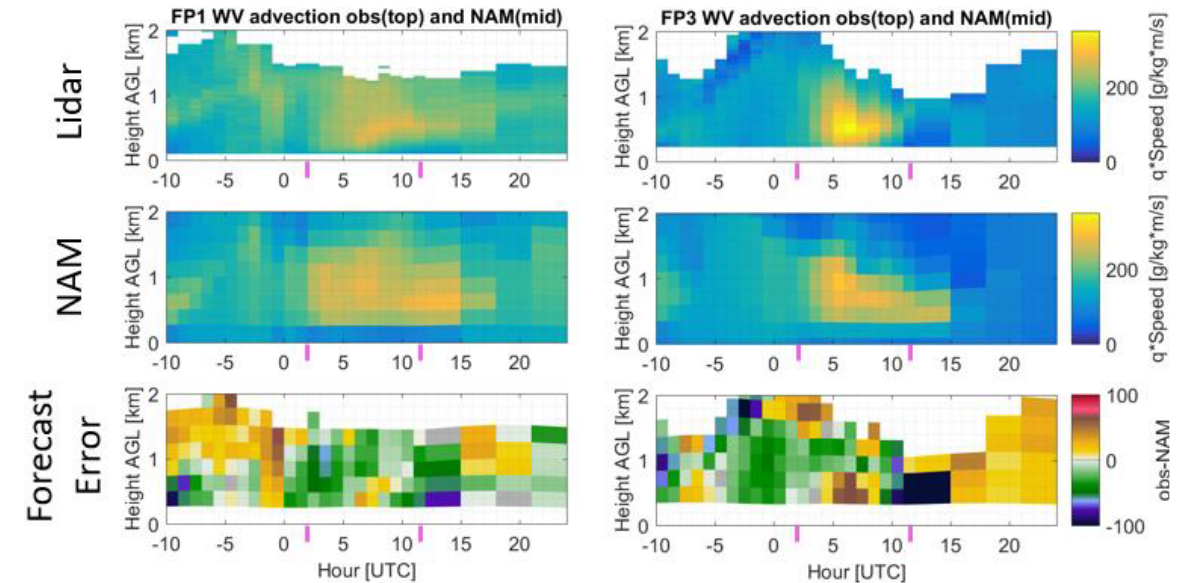
Figure 3. Water vapor ( WV ) mixing ratio ( q ) and advection profile timeseries from observations and NAM, along with forecast error (obs-NAM). Left column is at site FP1, right column is FP3. 0 on the x-axis is 0000 UTC, 11 July. Magenta lines indicate sunset (~0200 UTC) and sunrise (~11